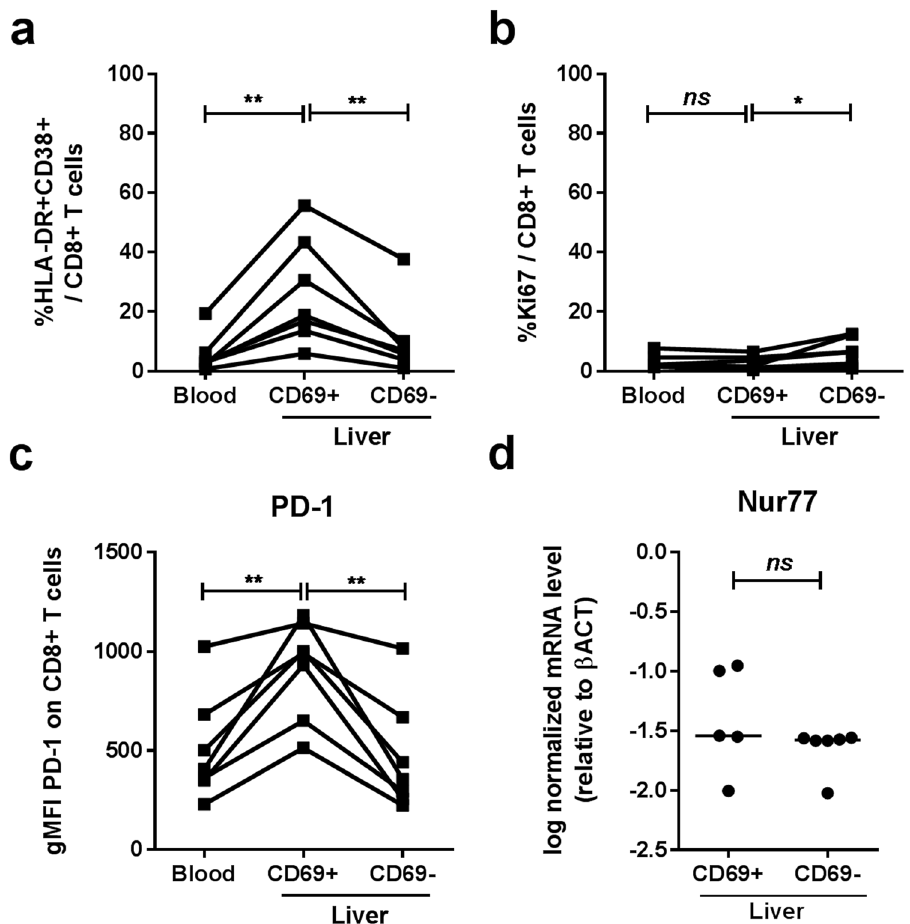
Figure 2. Frequency of HLA-DR + CD38 + double positive ( a ) and Ki67 ( b ) positive cells as a percentage of CD8 + T cells and gMFI of PD-1 ( c ) in control blood vs. liver (CD69 + and CD69-) CD8 + T cells. Statistical analyses; paired t-test. ** p < 0.01. ( d ) Relative expression of Nur77 in sorted CD69 + and CD69-CD8 + T cells from the liver (n = 6, one CD69 + sample was unavailable). Bars indicate median. Statistical analyses; Wilcoxon signed rank test. Abbreviations: ns,